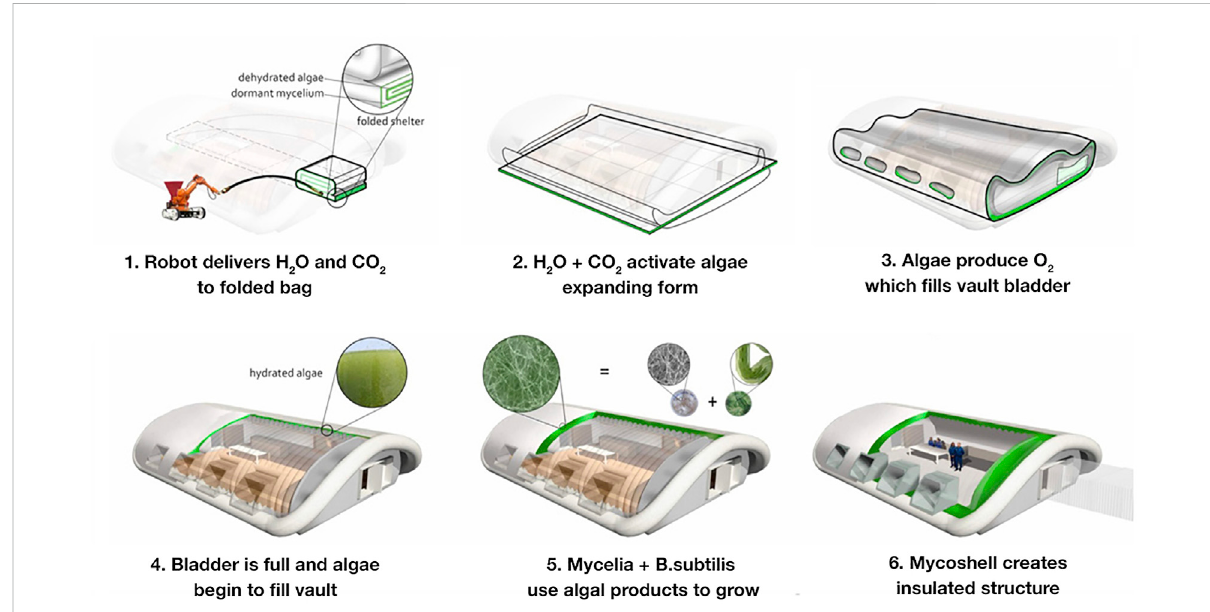
FIGURE 5 Fully encased in fl atable structures self-assemble when water, CO 2 , and heat are added by a robot, rehouse studio.